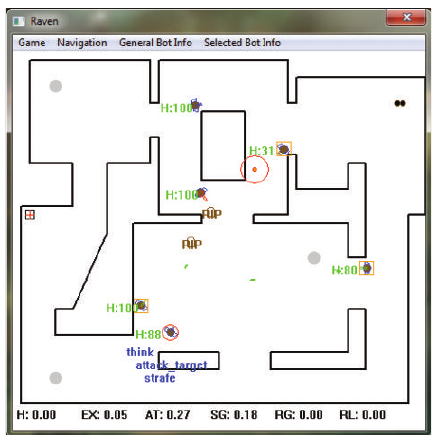
Figure 17: Raven with the modified targeting AI. The selected bot can be seen aiming at the enemy with low health (31), instead of the one close to it.